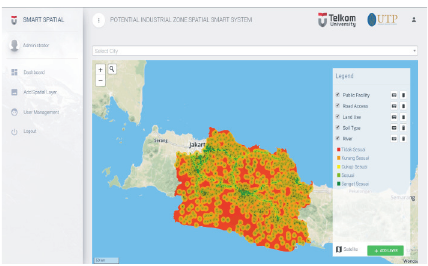
Figure 7: Application dashboard.